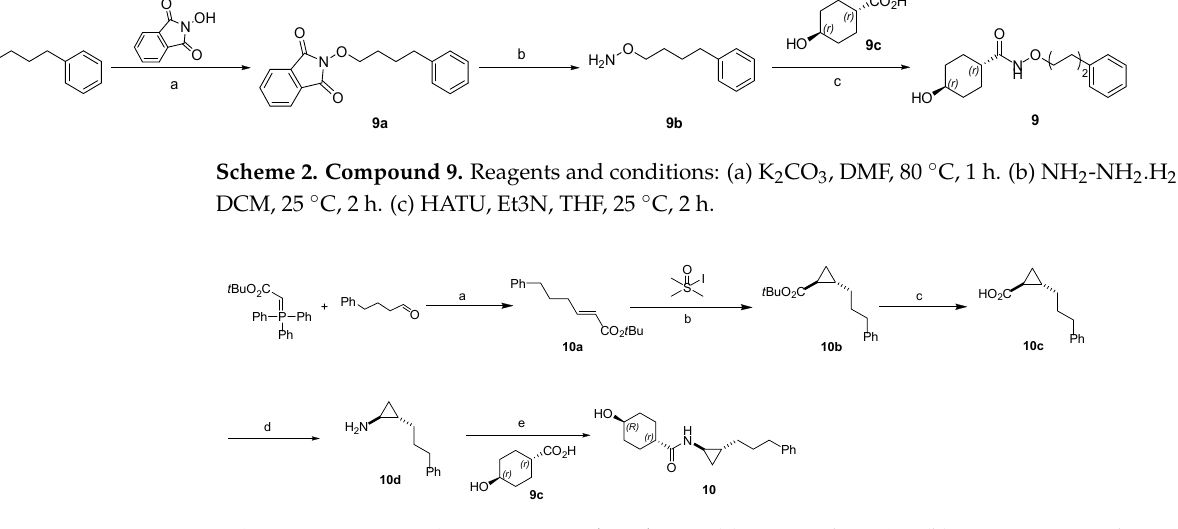
Scheme 3. Compound 10 Reagents and conditions: ( a ) THF, 12 h, 25 °C. ( b ) NaH, DMSO, 2 h, 25